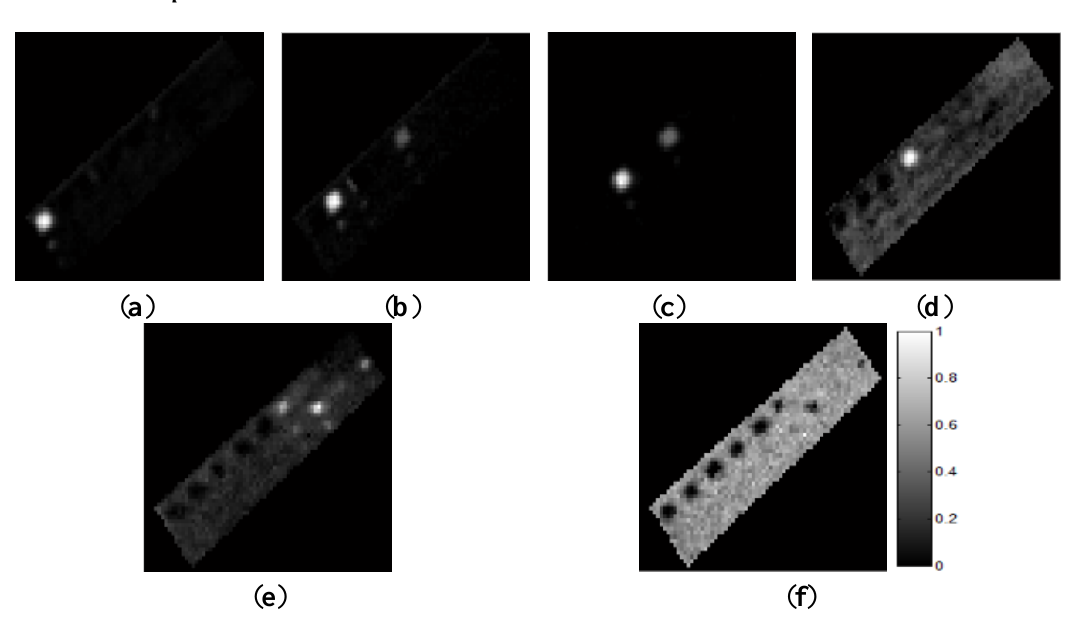
, ( b ) 𝐸 , ( c ) 𝐸 , ( d ) 𝐸 , ( e ) 𝐸 , and ( f ) 𝐸 3𝑝 5𝑝 4𝑝 2𝑝 1𝑝 7𝑝